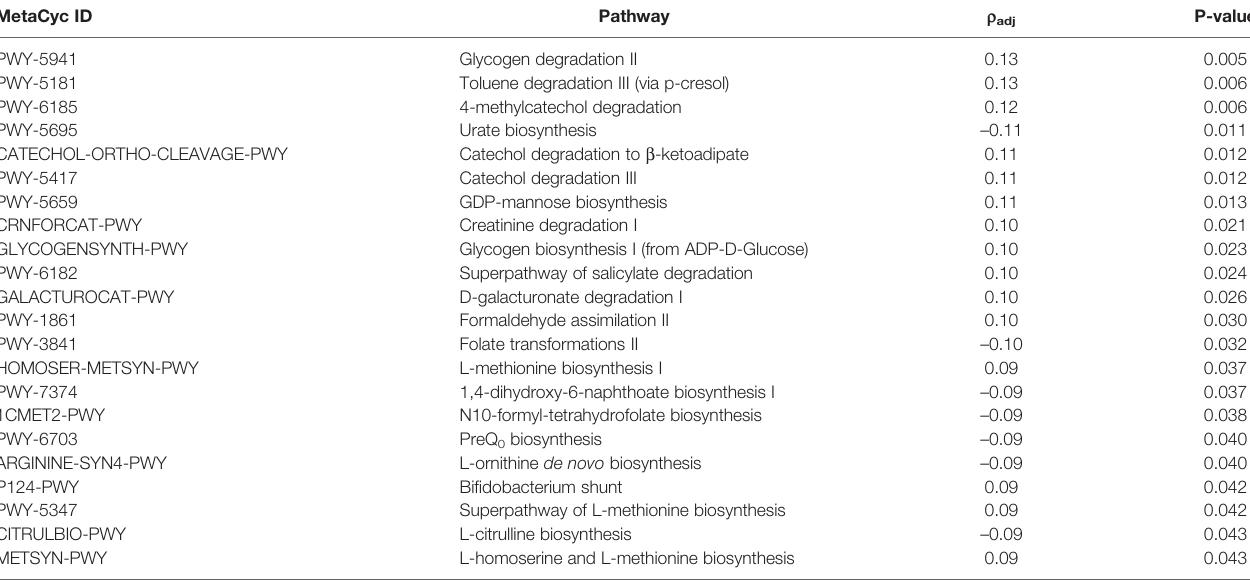
TABLE 3 | BMD associated microbial metabolic pathways. MetaCyc ID